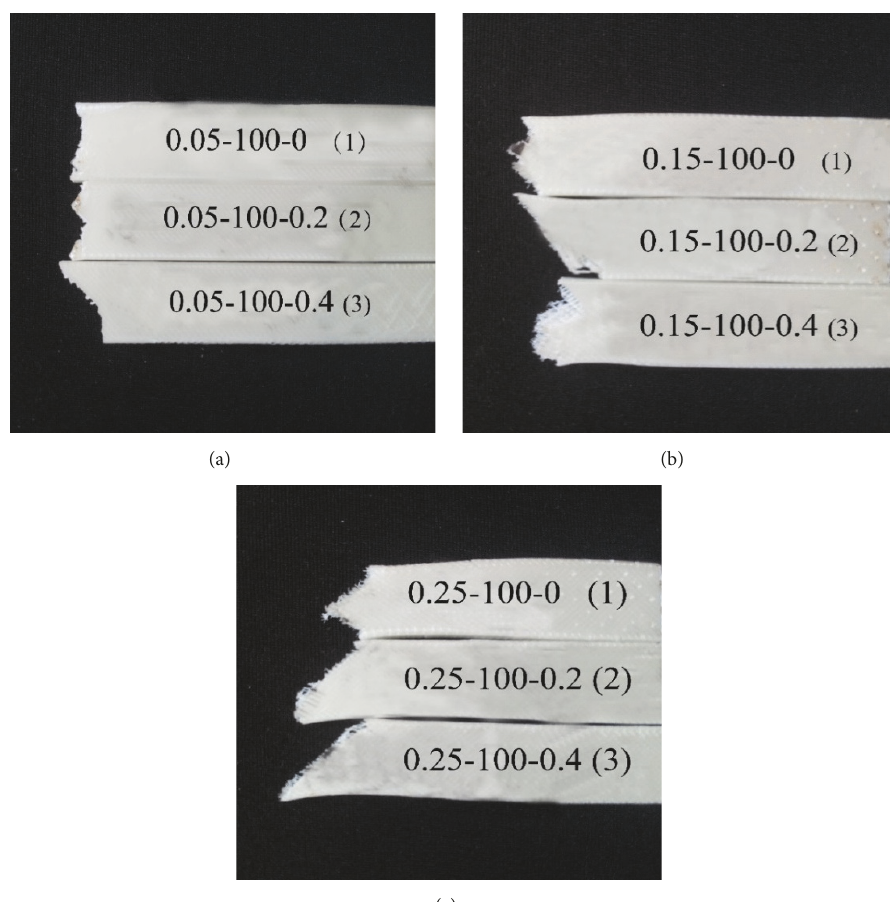
Figure 7: The failure specimen at different building levels of layer thickness and air